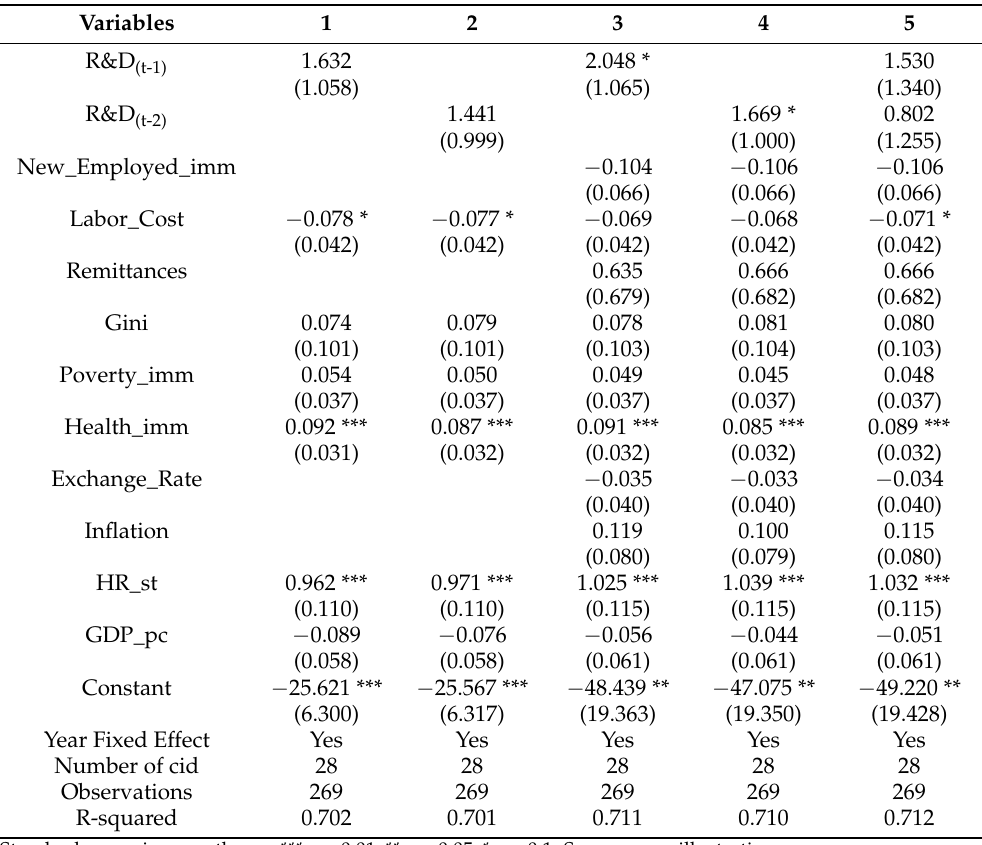
Table 1. Results of the panel specifications, dependent variable is the share of high-skilled immigrants